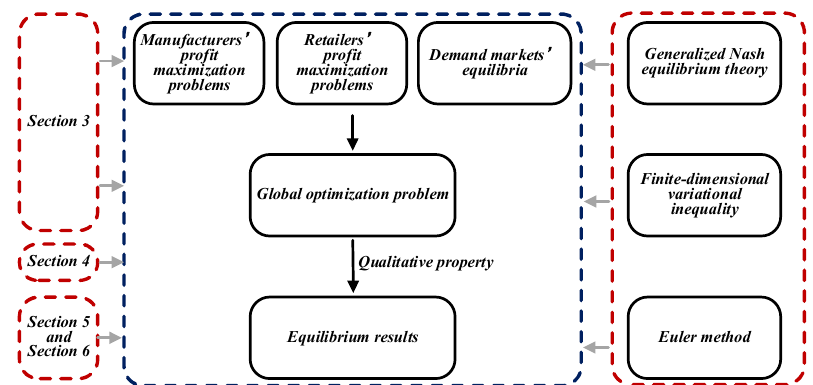
Figure 1. SCN structure.